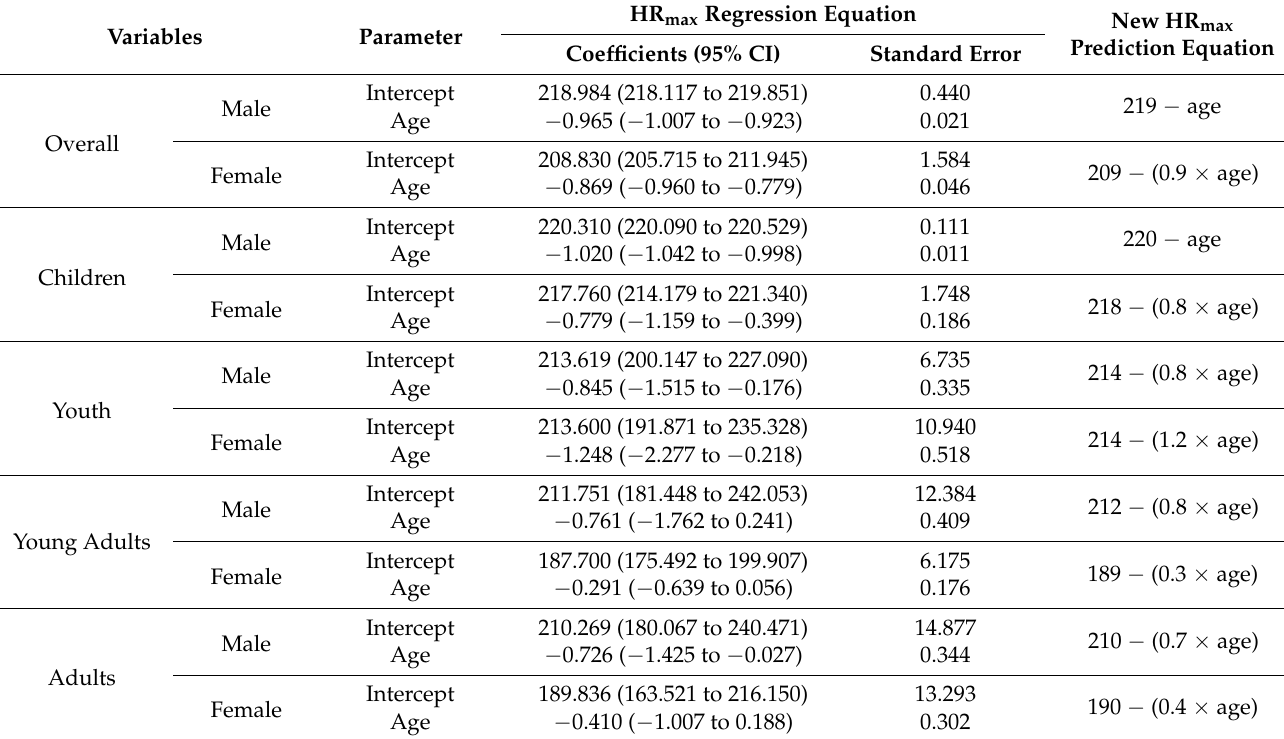
Table 3. Regression coefficients for estimating maximal heart